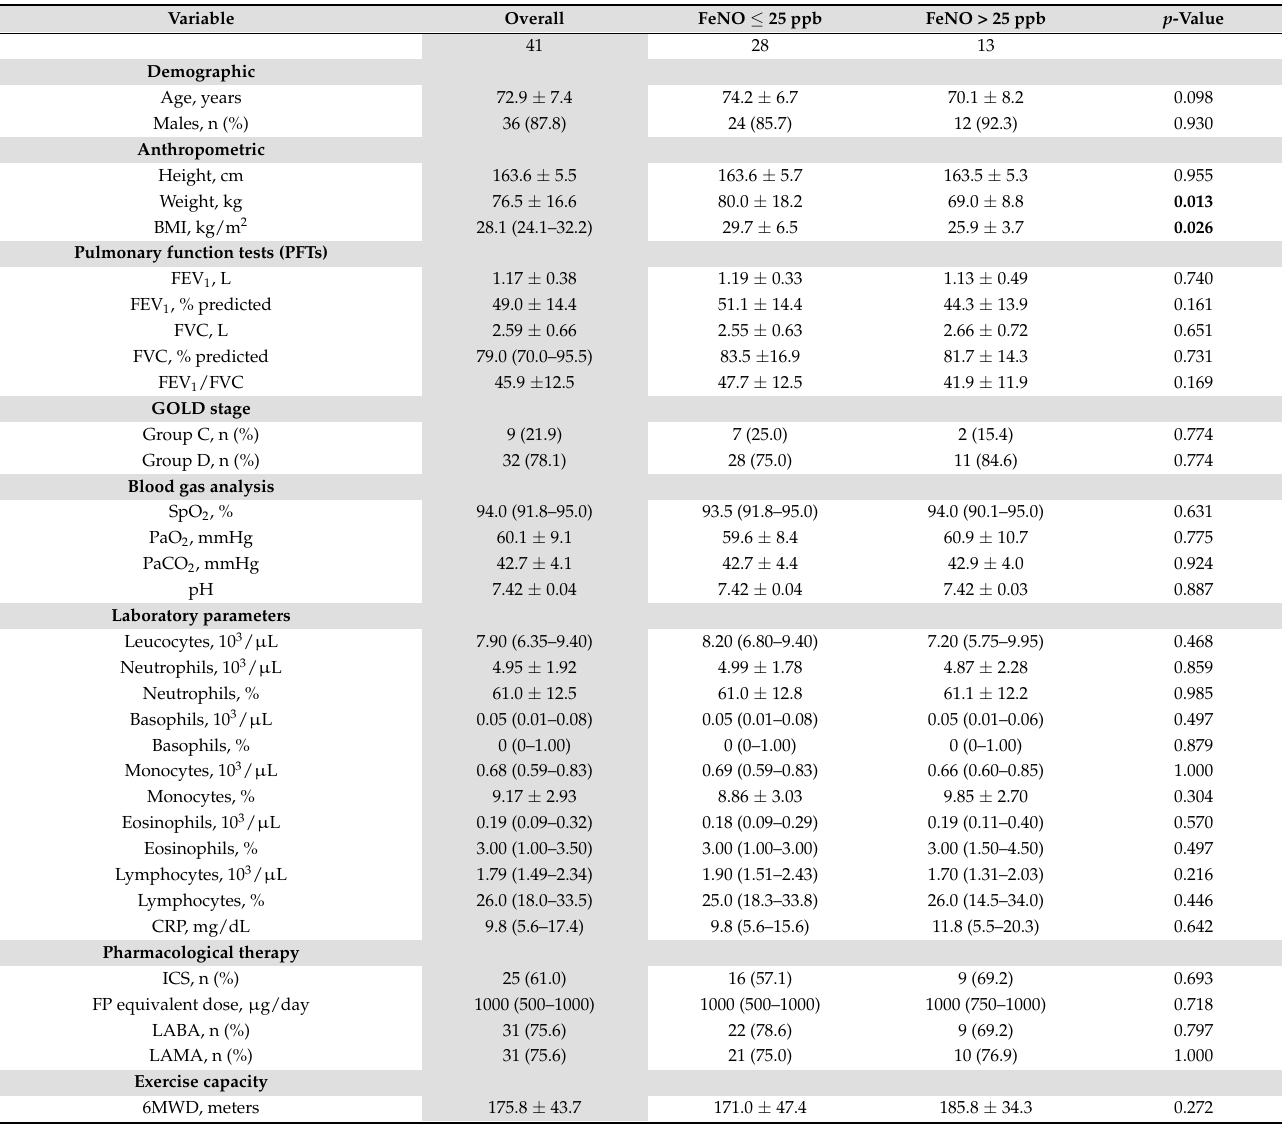
Table 1. Main demographic and clinical characteristics of chronic obstructive pulmonary disease (COPD)